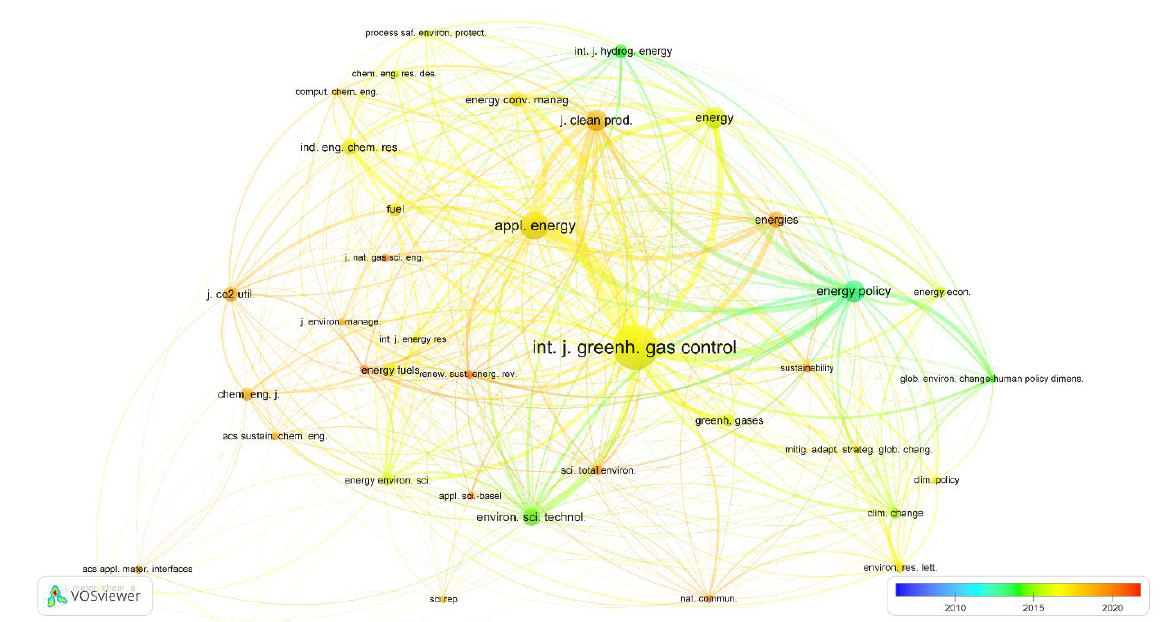
Figure 5. Visualization map of sources publishing research on carbon capture and